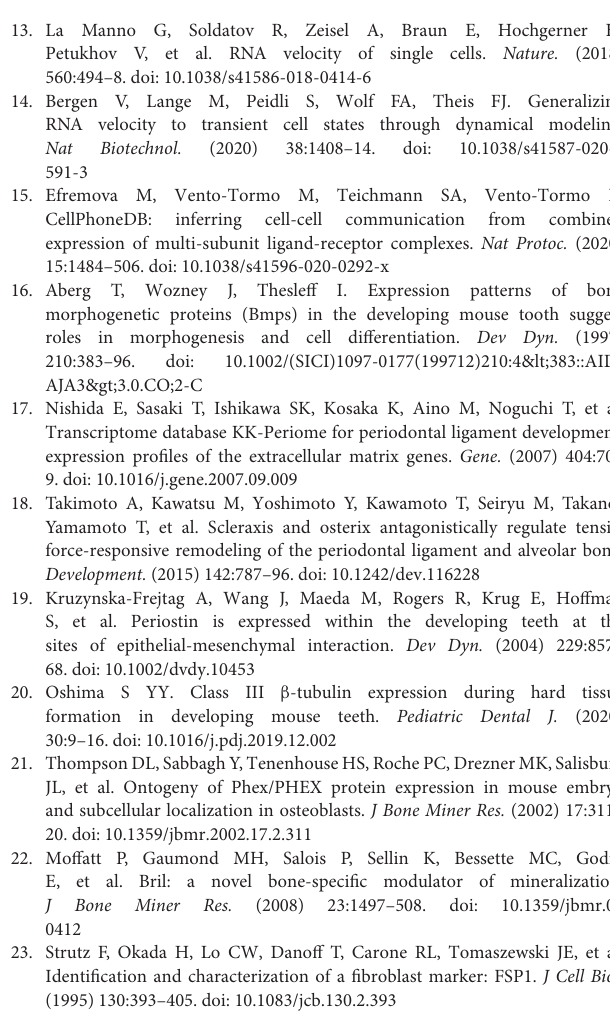
Supplementary Figure 1 | scRNA-seq analysis of PTHrP-mCherry + DF cells and Col1a1-GFP + periodontal mesenchymal lineage cells. (A) FACS-sorting strategy